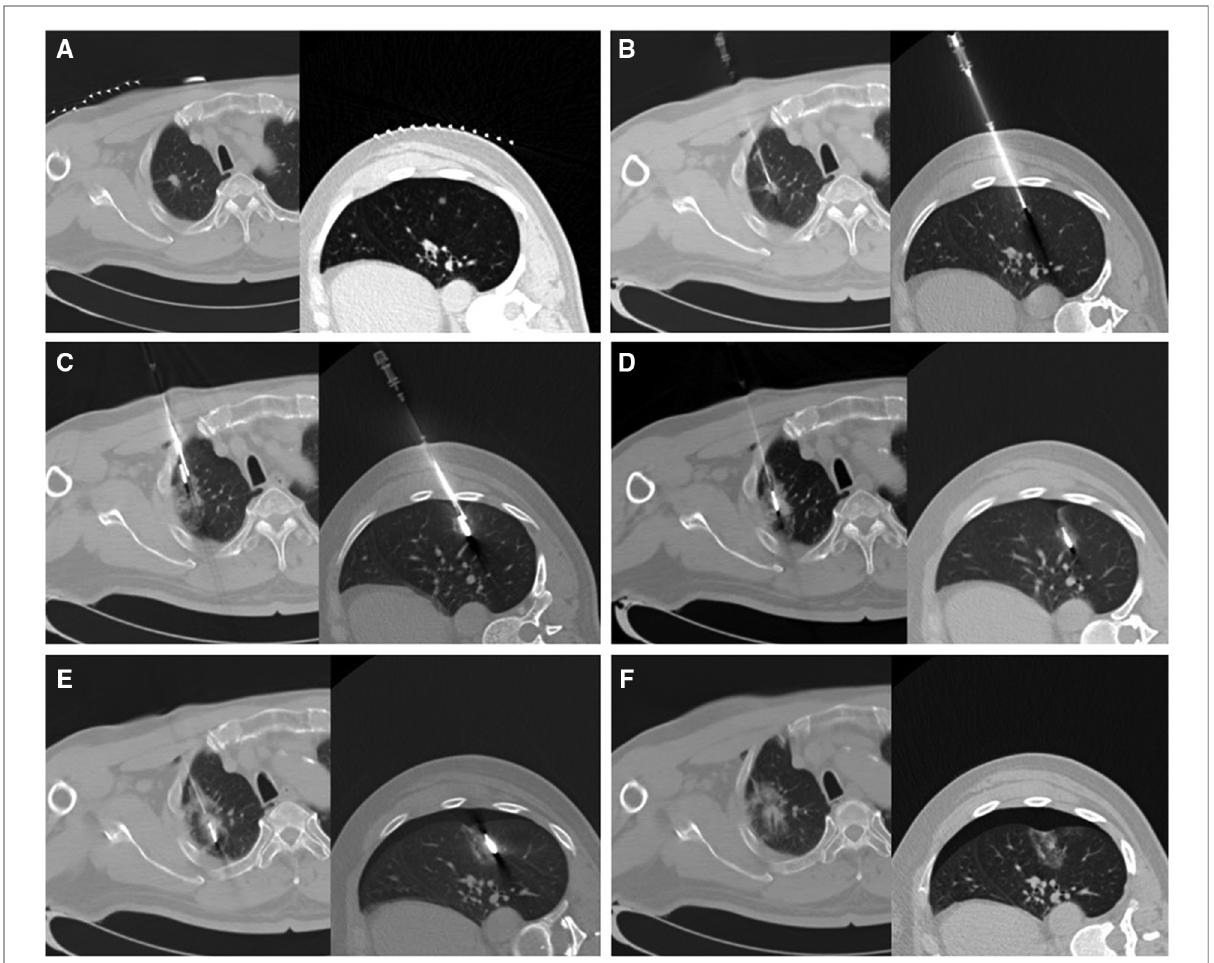
FIGURE 1 Case presentation. A 64-year-old female, presented with solid nodules in the right upper lobe and ground glass nodules in the left lower lobe. ( A ). Axial CT images of nodules in the upper lobe of the right lung and the lower lobe of the left lung ( B ). Under the guidance of CT, the needle was inserted into the target site of the nodules, and the samples were cut and sampled. ( C ). Under the guidance of CT, the ablation needle was entered into the target site of the nodule, and the two needles were in the same fi eld of vision ( D ). After pre-ablation, the samples were cut again, and the CT images were reviewed. ( E ). After adjusting the ablation parameters, continue the ablation until the ablation range is satisfactory. ( F ). Immediately after the end of the ablation, CT review showed a little bleeding and pneumothorax.